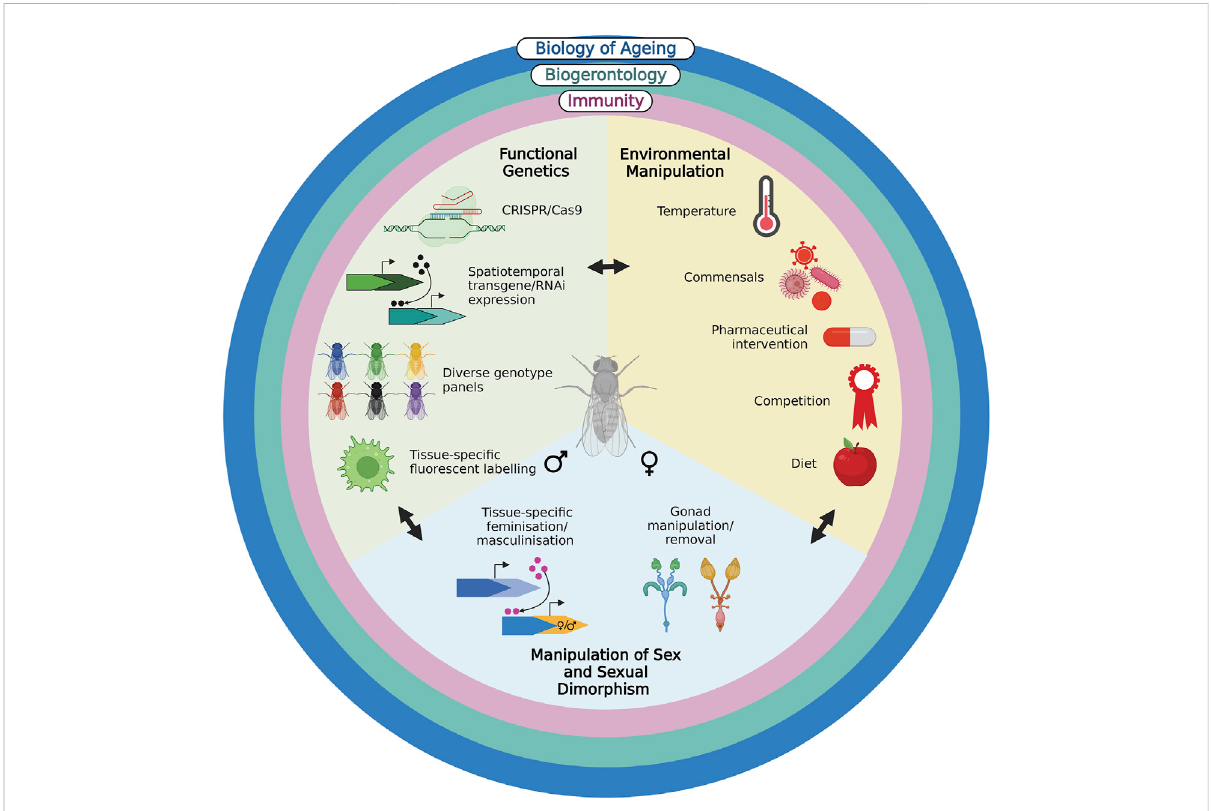
FIGURE 1 Drosophila ’ s rich history in the fi elds of evolutionary biology of ageing, biogerontology and immunity have endowed the model with multiple conceptual approaches and techniques. The functional genetic approaches, ease of environmental and sex manipulation render it invaluable in understanding natural variation in immunosenescence and its potential treatments. Created with